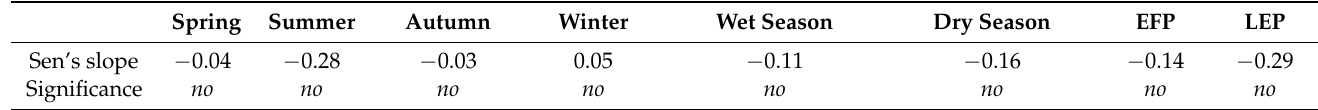
Table 3. The mean annual change trend of seasonal rainfall (mm/a) over the Loess Plateau, China. Spring